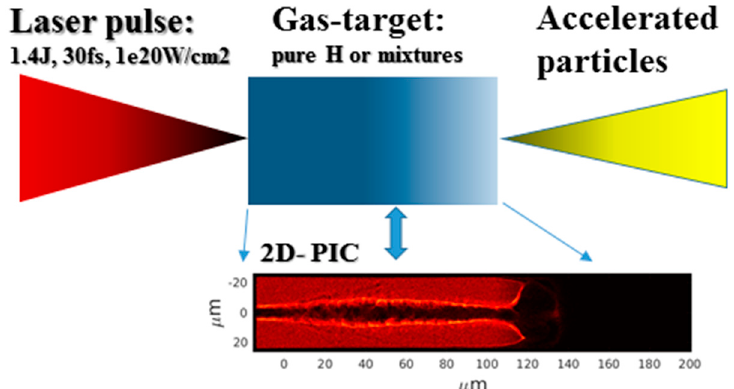
Figure 1. Conceptual setup of the experiment simulated into the 2D-PIC (Particle-In-Cell). The laser, consisting of 1.4 J energy, 30 fs pulse duration and of which focused on a focal spot of 3 µ m-FWHM (Full-Width at Half-Maximum) to reach a peak intensity of 10 20 W / cm 2 , enters at the left side, which we will name hereafter “plasma input”. The right edge will hereafter be named “plasma output”. In order to verify the e ff ect of the background plasma density, as well as to select the best case